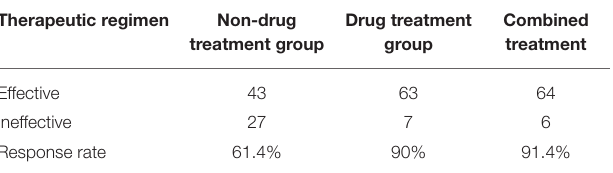
TABLE 2 | Comparison of